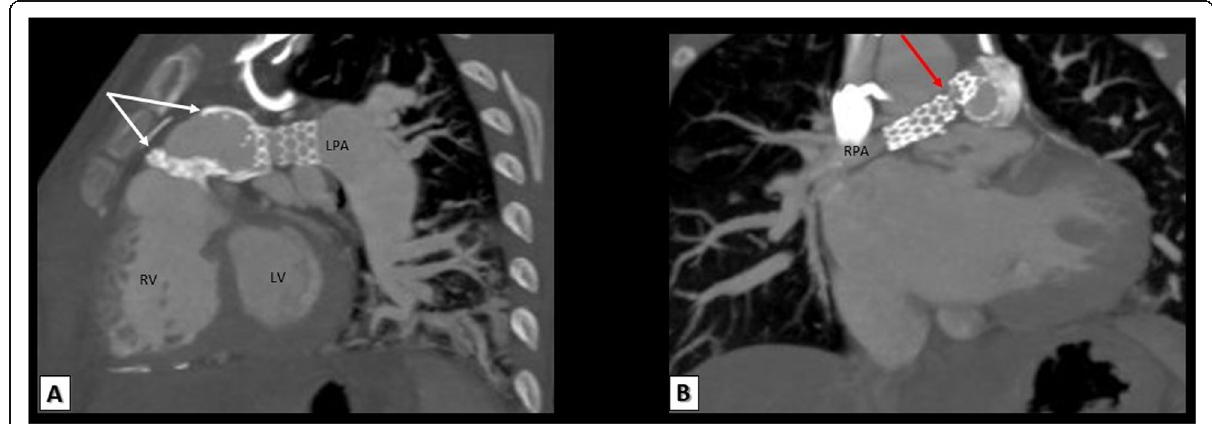
Fig. 14 Images of a surgically repaired TOF patient with RV-PA conduit and bilateral branch pulmonary artery stenting. a Reconstructed sagittal and b reconstructed coronal MDCT images showing marked calcifications of the RV-PA conduit. Note the fractured RPA stent (red arrow). RPA, right pulmonary artery; LPA, left pulmonary artery; LV, left ventricle; RV, right